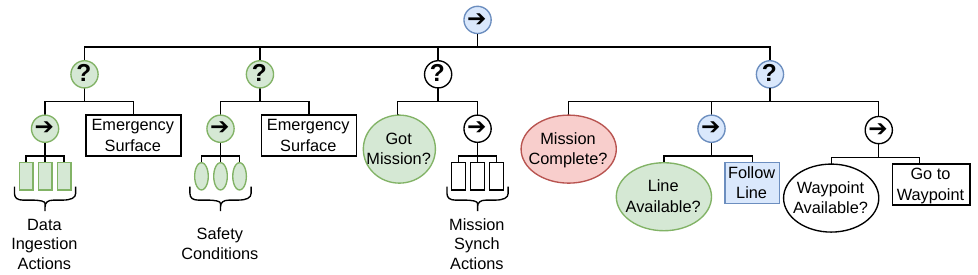
Figure 5. A high-level view of a simple example BT that could be used for the seaweed farm. Inner nodes are Sequences (arrows) and Fallbacks (question marks). Leaf nodes are Actions (rectangle) and Conditions (ellipse). All nodes can return Success (green), Failure (red), and Running (blue). In this example, the vehicle has all the data it needs, is within safety limits, has an incomplete mission, and is currently following a